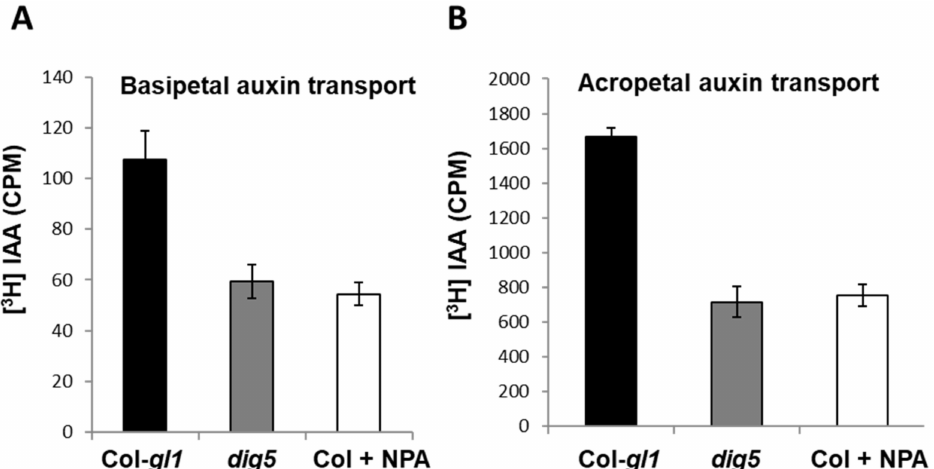
Figure 5. Polar auxin transport in roots of dig5 and wild type seedlings. ( A ) Basipetal auxin transport. ( B ) Acropetal auxin transport. 100 nM [ 3 H]-IAA with or without NPA (100 µ M) was applied either to the root tip ( A ) or shoot-root junction ( B ) of seedlings on agar plates followed by incubation in the dark for 5 h ( A ) or 16 h ( B ). The distal segments of the roots were harvested to measure the radioactivity. Data were means and standard errors of 3 replicates, each with at least 10